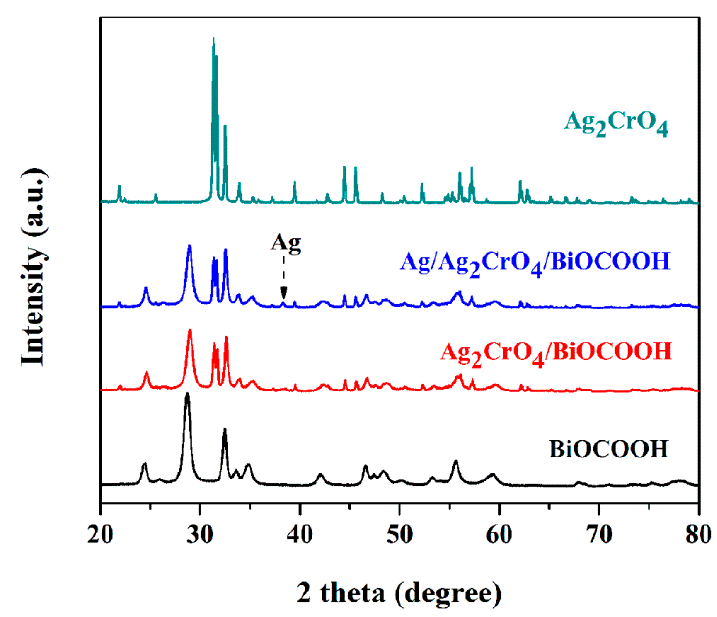
/ Ag / BiOCOOH 2 CrO 4